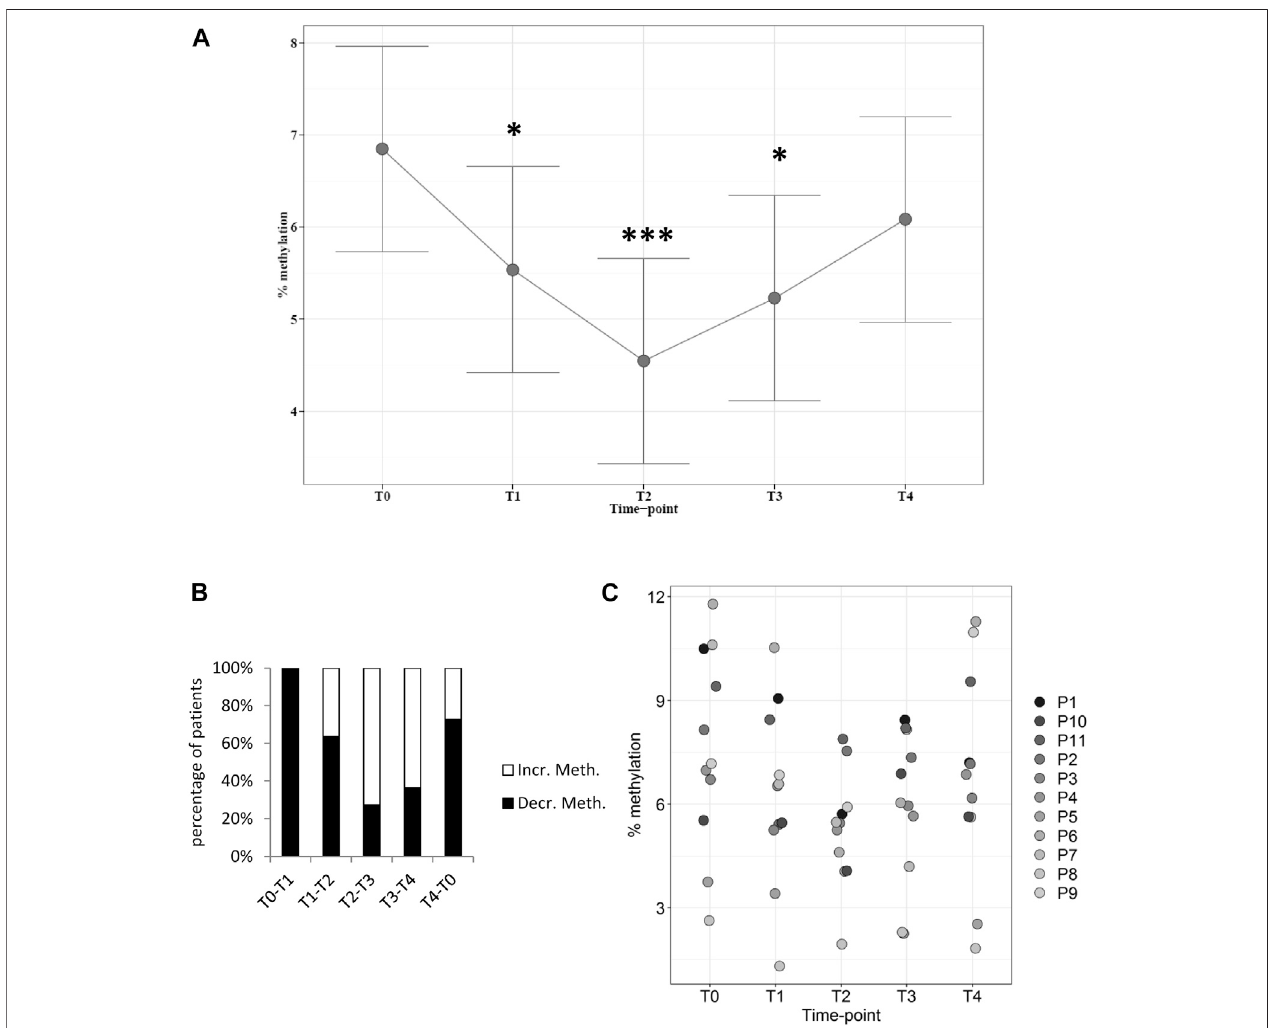
FIGURE 1 | Global DNA methylation levels in patients at different time-points. (A) : Plot of the least square predicted means with 95% con fi dence intervals. The predicted least square means were calculated using a 1-way repeated measures mixed model. * p < 0.05; *** p < 0.001 in planned comparisons with T0 levels. (B) : variationinmethylationlevelsbetweentime-points.Thepercentageofpatientsshowingincreased(Incr.Meth.)ordecreased(Decr.Meth.)methylationlevelswithrespect to the previous time-point is shown. (C) : DNA methylation levels in each patient at every time-point. n (cid:2) 11 patients repeatedly assessed at 5 time-points.